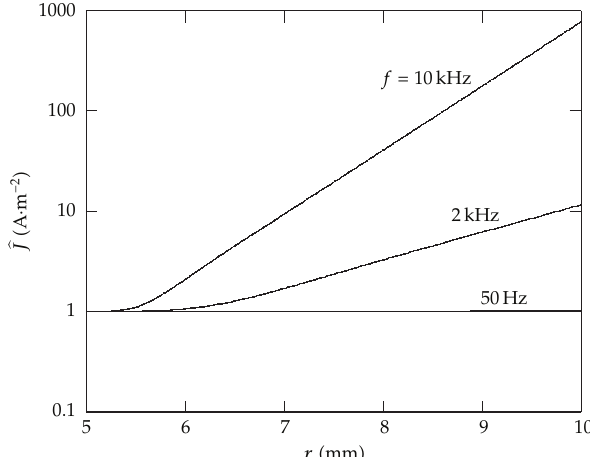
Figure 3: Dependence of current density module on r in Example 3.1; number of partial conductors m (cid:7)